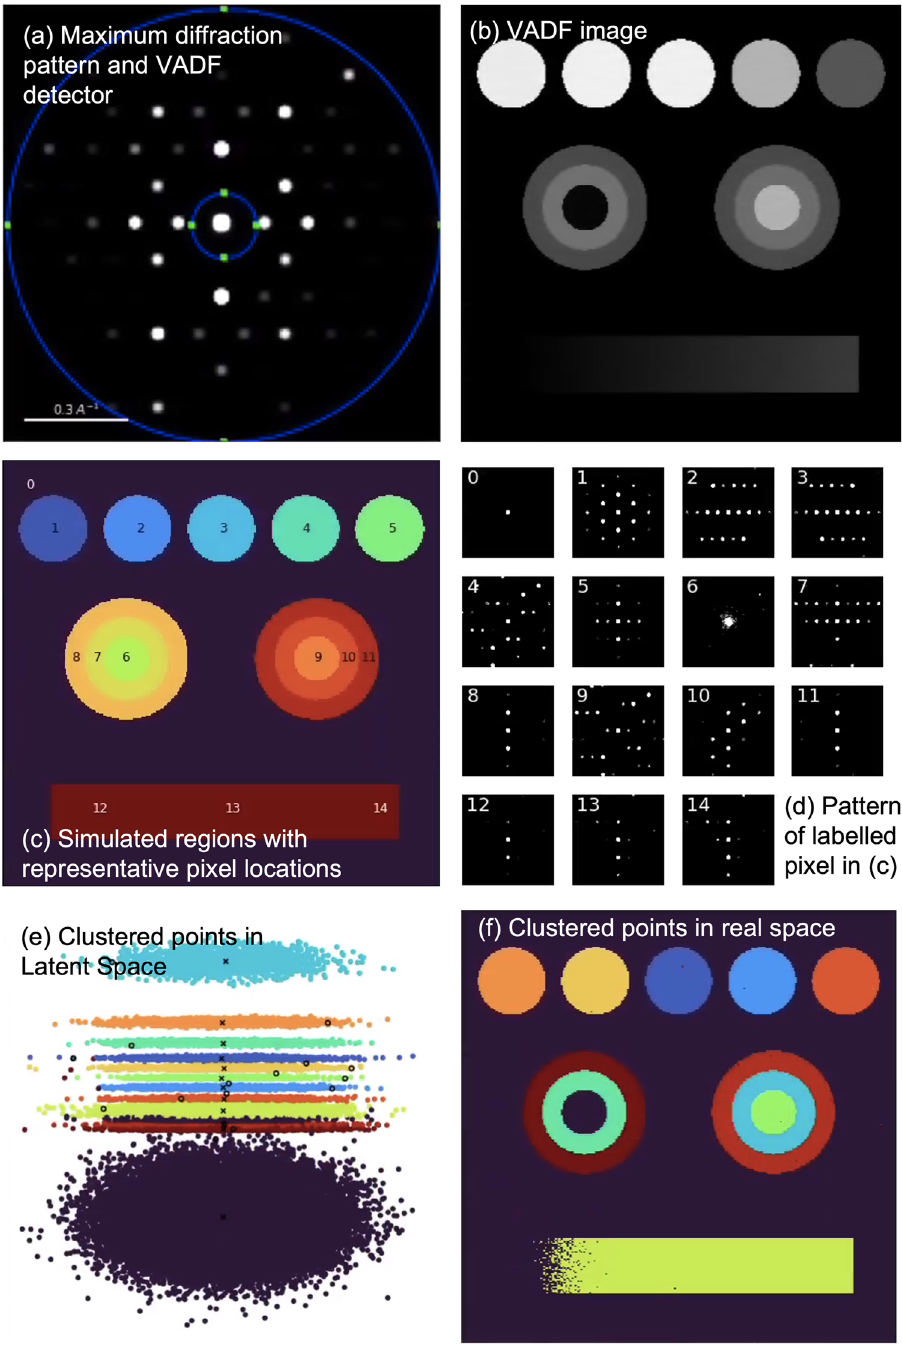
Fig. 4 Example domain mapping of a simulated dataset. a The maximum diffraction pattern of the entire dataset with a virtual annular detector. The scale bar represents a length of 0.3 Å − 1 . b The virtual annular dark fi eld (VADF) image for the simulated layered metal oxide (LMO) sample dataset. c The region map used to populate the simulated dataset, each region contains patterns of the same crystal structure (or amorphous structure) and orientation but with added noise (and variation in thickness for the bar at the bottom). Pixel locations have been indicated with numbers to aid the understanding of the patterns which populate the dataset. d The diffraction pattern corresponding to the pixel locations highlighted in ( c ). e The encoded positions of the patterns clustered by colour. The open black circles show the initial centroids identi fi ed by NMF and re fi ned by SSI. The black crosses show the new centroids by averaging the locations of points within clusters. f The clustering on the real space pixel locations, a pixel location has been highlighted in each of the identi fi ed can be seen to span across various point densities). This is a similar cluster the navigation region using 16 components in the NMF as case to that of the thickness effects for the simulated data, as indicated in Fig. 5. From the clustering in Fig. 5d, it can be observed that the there is a deviation from where one might anticipate boundaries, boundaries of the classes do not precisely follow the gaps but again, this is the result of regions with insigni fi cantly low between the more dense point encodings (the yellow-green class diffraction intensity merging. Inspection of the resulting patterns